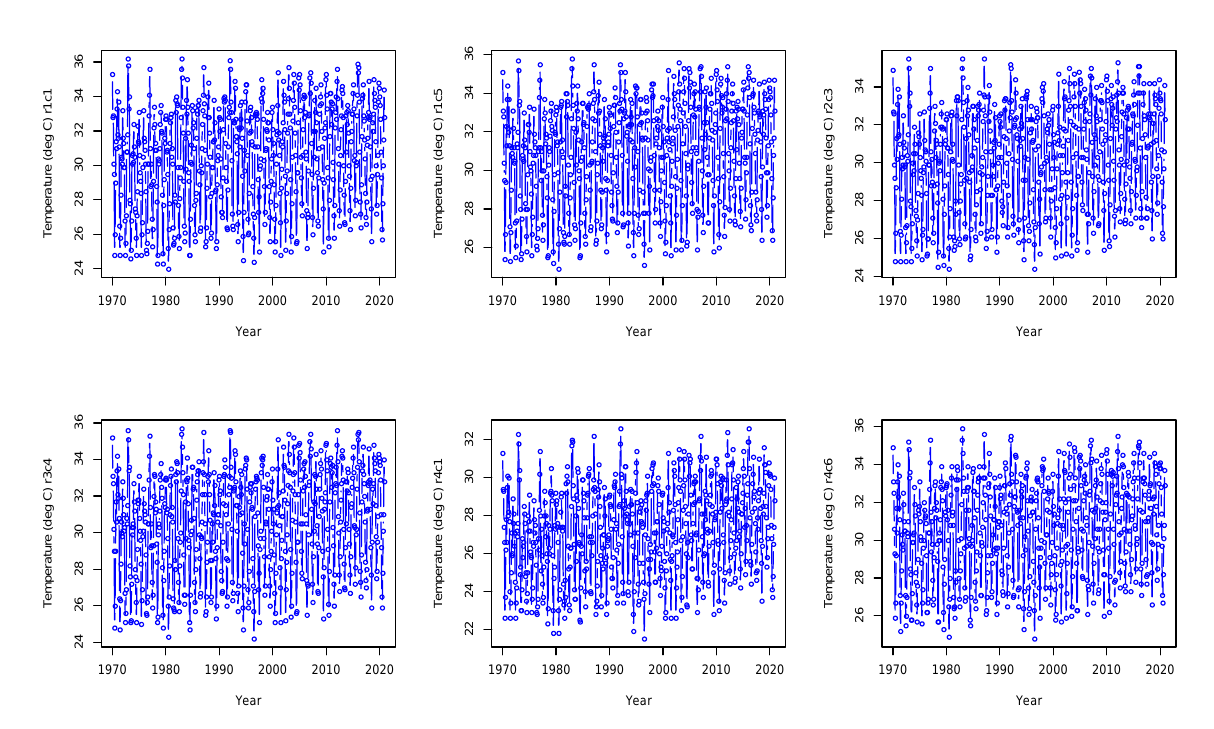
Figure 7. Plots of temperature for the grids: r1c1, r1c5, r2c3, r3c4, r4c1 and r4c6.